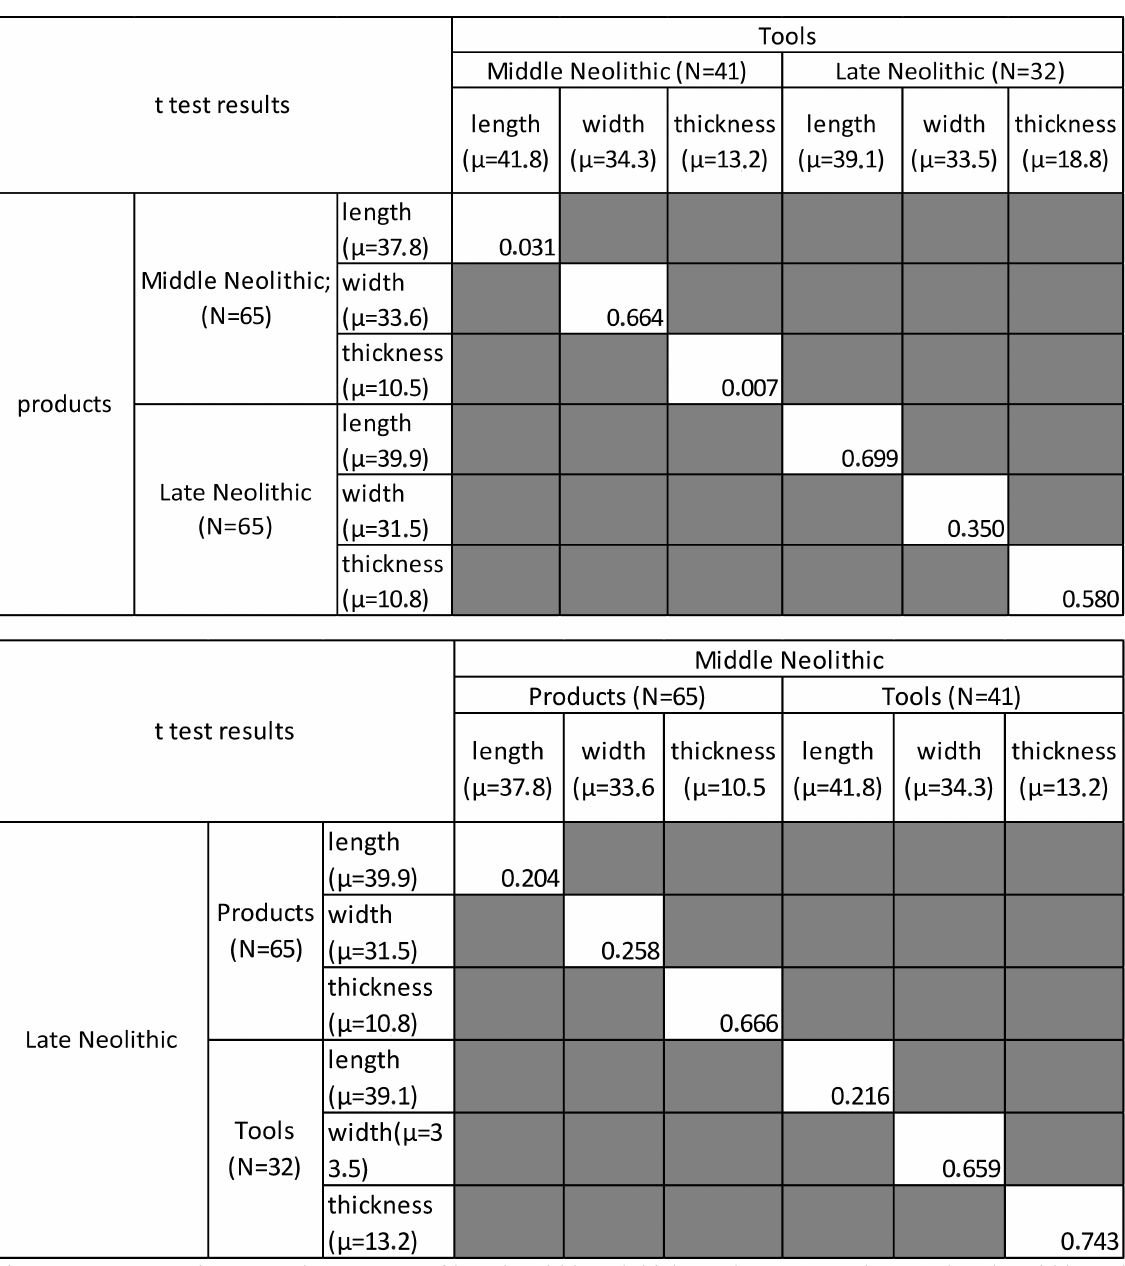
Figure 6. T-test results comparing average of length, width and thickness between products and tools, within and between